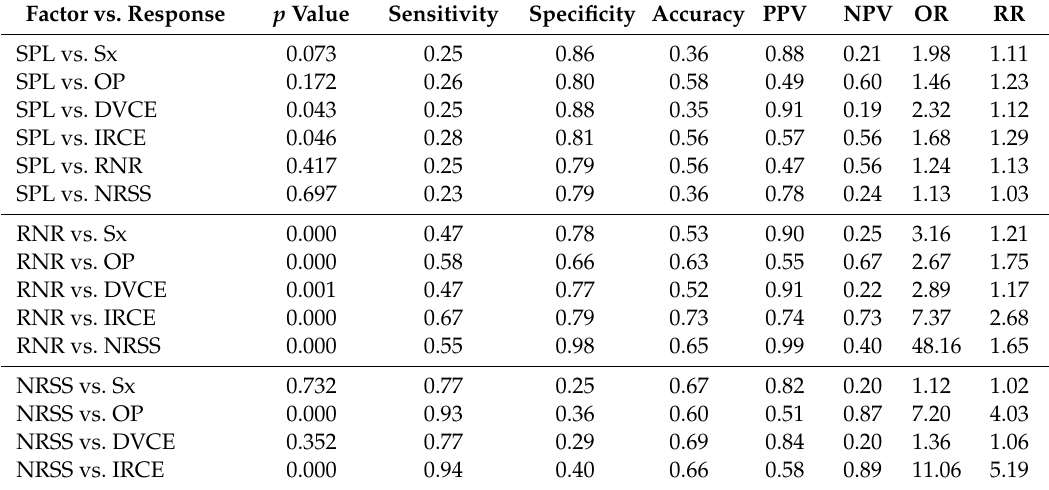
Table 4. Clinical relationship with enhancement patterns of SPL, RNR,